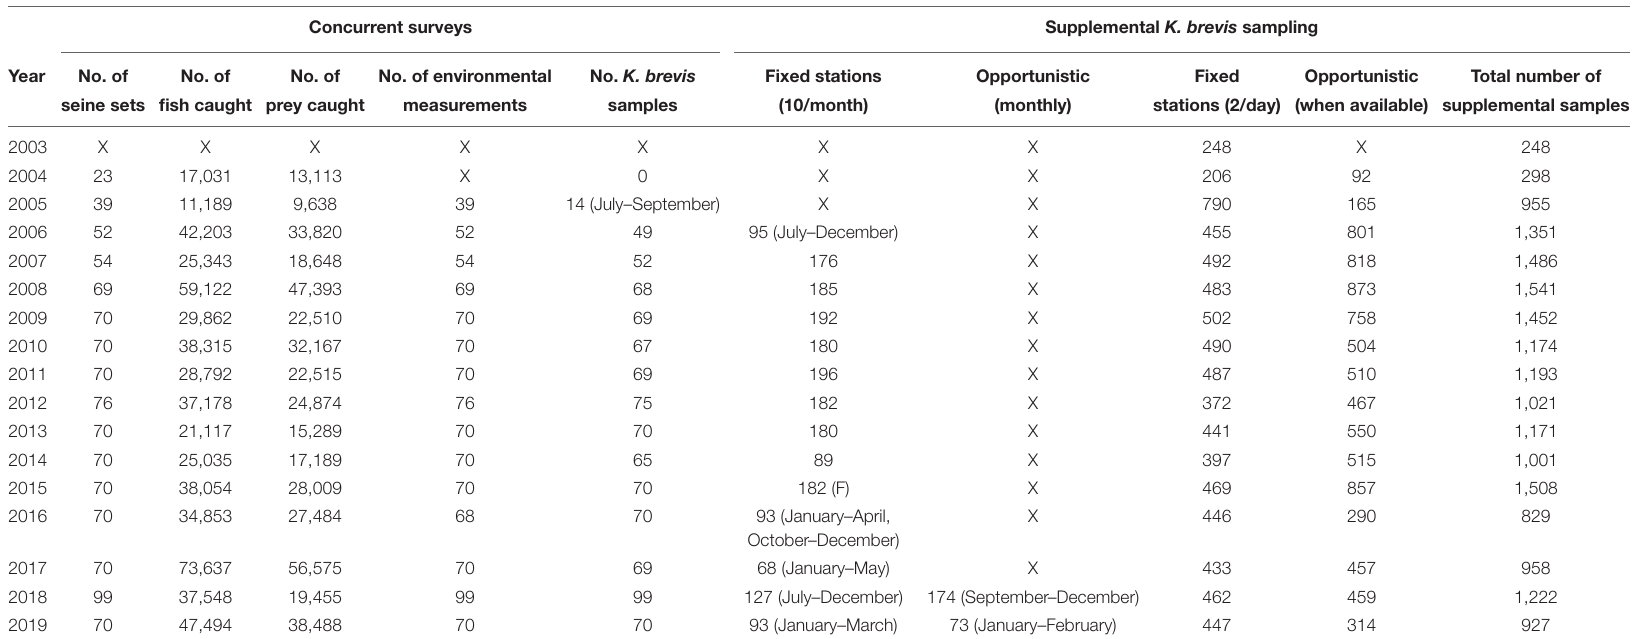
TABLE 1 | Summary of sampling chronology and effort during, (1) concurrent random surveys of fish, environmental variable, and Karenia brevis sampling in the summer and winter months, and (2) supplemental K. brevis sampling throughout the Sarasota Bay study area during 2003–2019. Concurrent